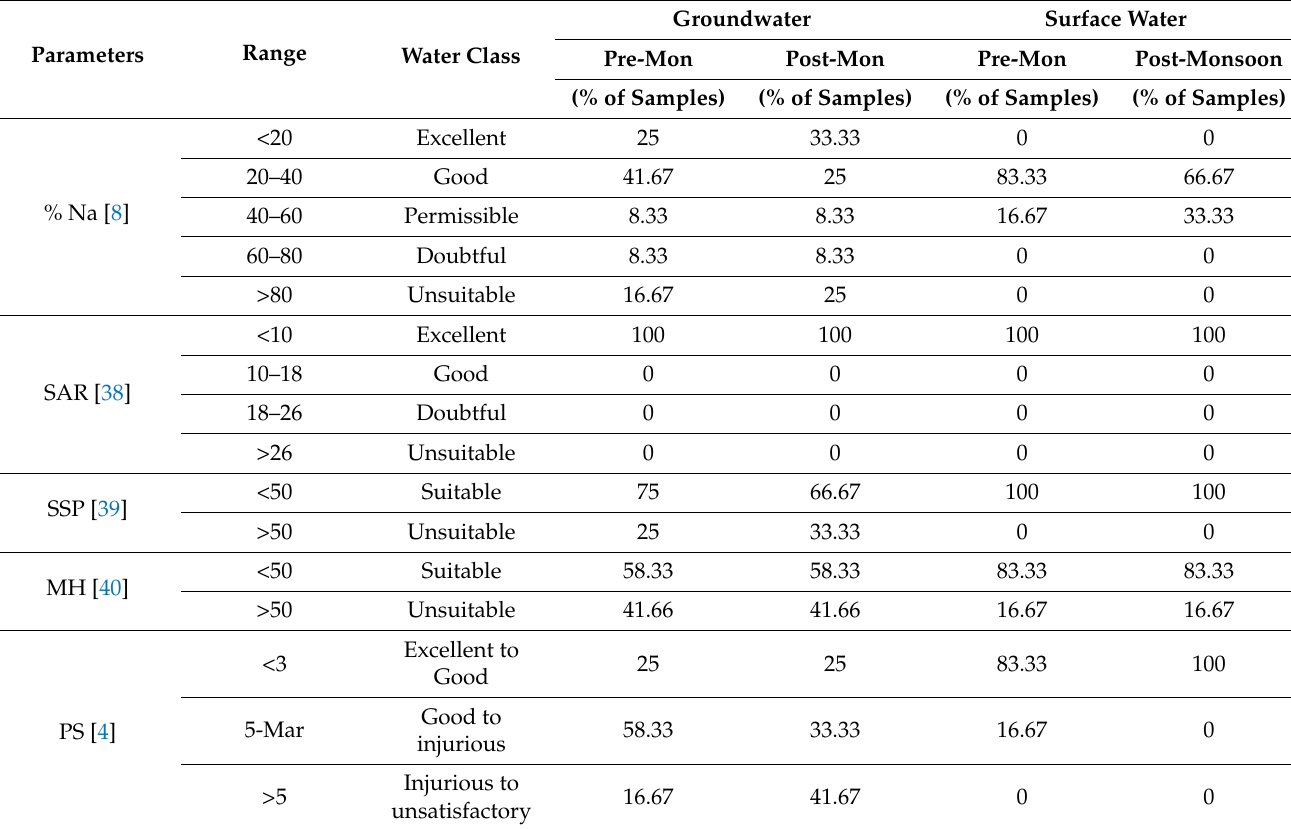
Table 5. Classification of surface water and groundwater based on irrigation